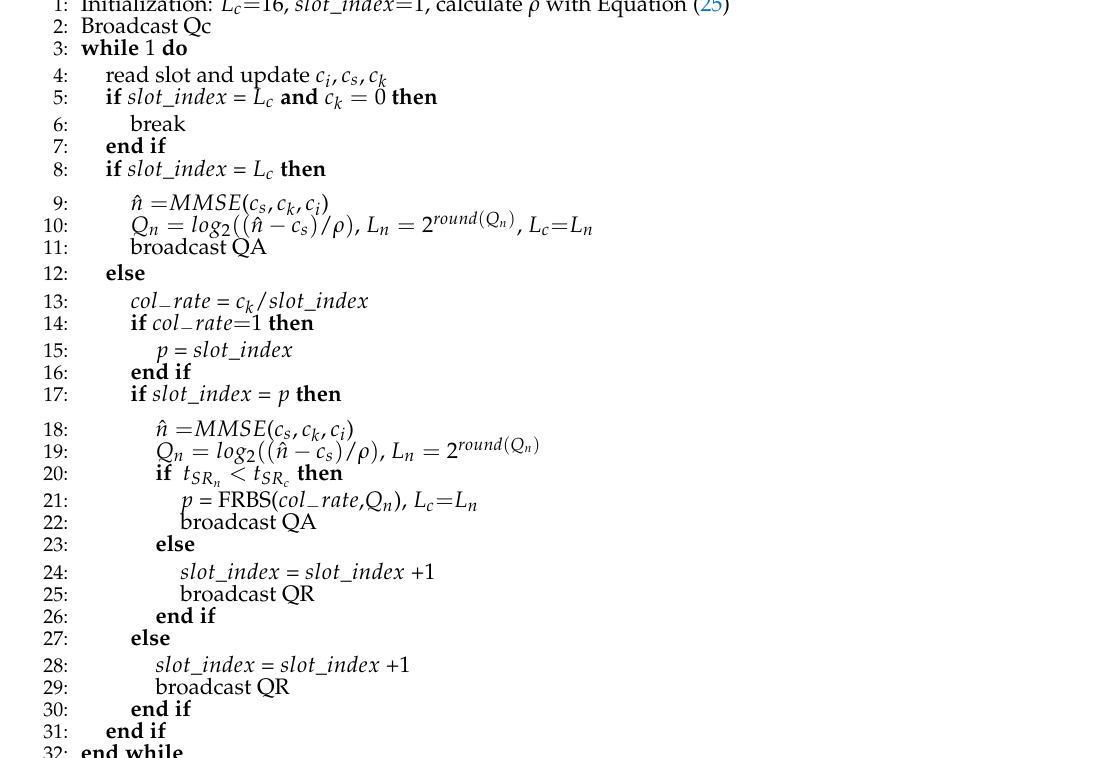
Algorithm 1: Pseudocode of Fuzzy Frame Slotted Aloha (FFSA) protocol, reader